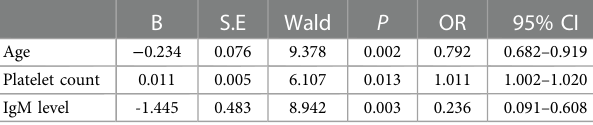
TABLE 2 Logistic regression analysis of predictors for testicular/ epididymal involvement in IgAV